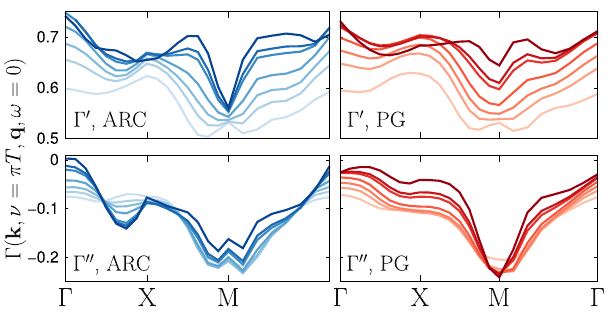
Fig. 4 Real and imaginary part of the spin-fermion vertex for ARC and PG as a function of q. Shadings from dark to light: δ = 0.01, 0.05, 0.07, 0.12, 0.16, 0.2,